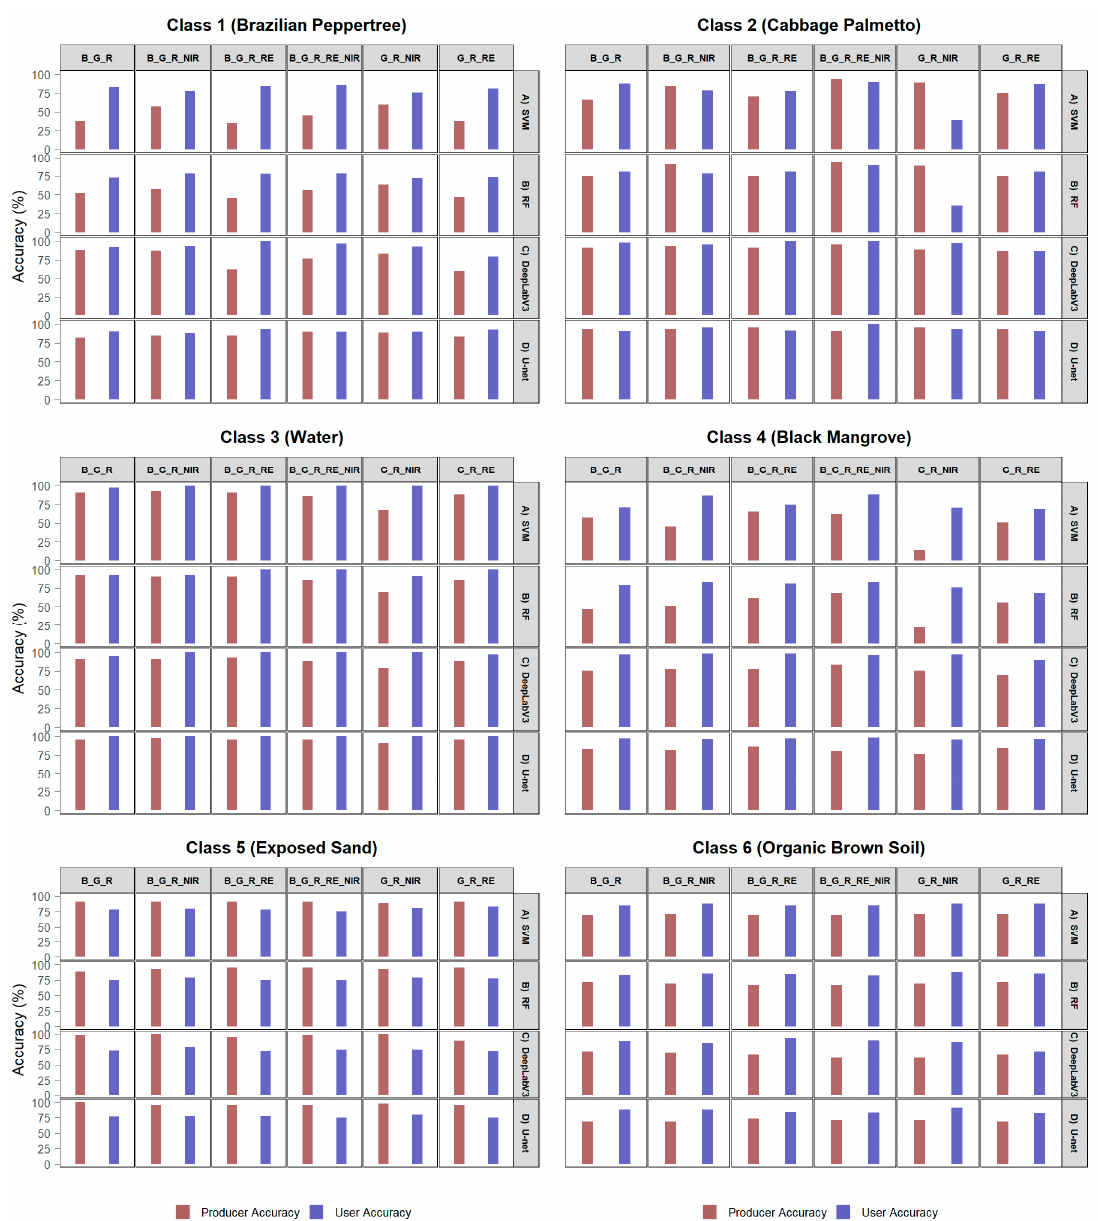
Figure A1. Experiment: EXP1-OSB, producer and user accuracy organized by class and classification method, classes 1 to 6.